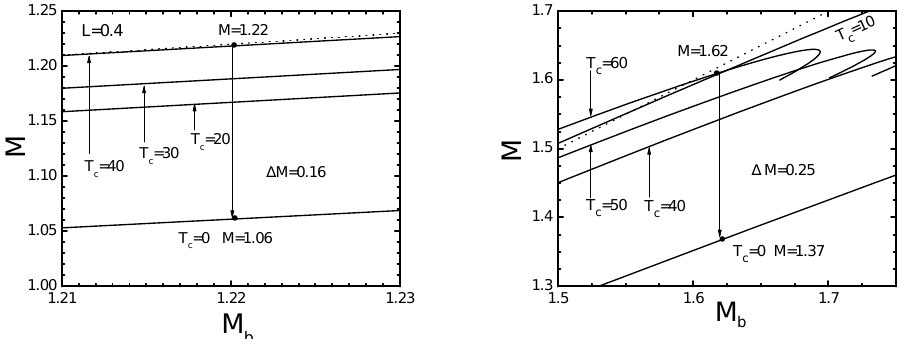
Figure 1. The dependence of the mass of the quark star M on the baryonic mass M b for different central temperatures T c for regions 1.21 ≤ M b ≤ 1.23 (left panel) and 1.5 ≤ M b ≤ 1.75 (right panel). The relative lepton charge is L = 0.4, which is less than 26/56 (corresponding to the Z / A -ratio for iron) to compensate the partial escape of neutrinos before the formation proto-quark star (PQS). We also show the same dependence for cold (zero-temperature) quark stars. All of the masses are given in units of the solar mass and the temperatures are given in MeV. The circles mark the positions of stars with masses of 1.22 and 1.62. All curves correspond to the uds quark stars, except the T c = 10 MeV curve, which corresponds to ud -PQS. The dotted line corresponds to the line M = M b